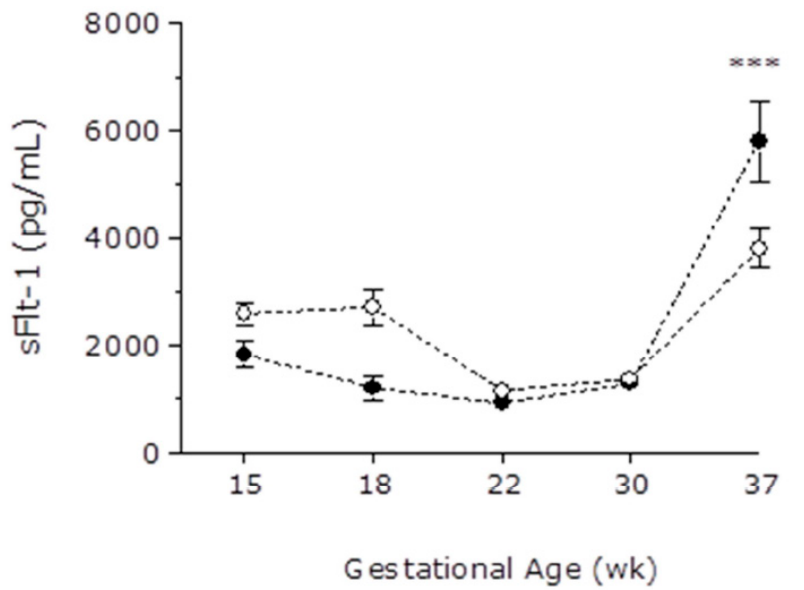
Figure 1. Maternal plasma concentrations of soluble fms-like tyrosine kinase (sFlt-1) in the control group (white points) and pregnant women affected by breast cancer (black points). Differences were analyzed by two-way analysis of variance. Data are presented as mean with standard error mean (SEM). ***, p < 0.001.